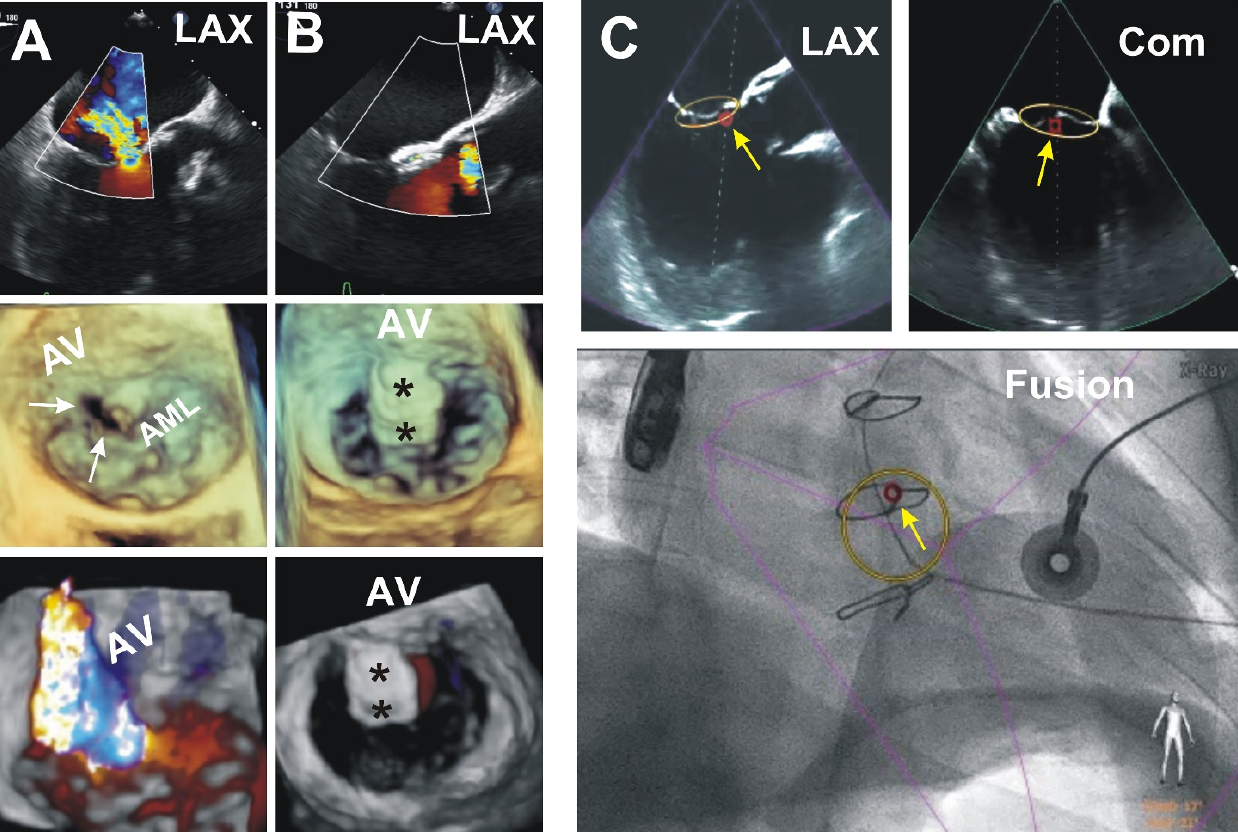
Figure 4. EFF scenario “Free view of the TEE probe”. This figure represents the closure of the two defects in the native anterior mitral valve leaflet (AML). C-arm positioned at 17° Caud and 21° RAO. ( A , B ) panels—pre- and postprocedural views of the mitral valve in the long axis (LAX) TEE view with Color Doppler (top). 3D TEE “surgical view” (middle). 3D Color Doppler TEE (bottom). I and II—two defects in the AML. White arrows point to the defects. Black stars—the occluders in the AML. ( C ) panel (top)—long axis view (LAX) and commissural views (Com) perpendicular to each other. Software use labeled mitral annulus with anatomical marker—yellow circle and location of the defects—small red circle. Yellow arrows point to the defects. ( C ) panel, bottom—anatomical markers transferred by EFF software onto fluoroscopy screen.